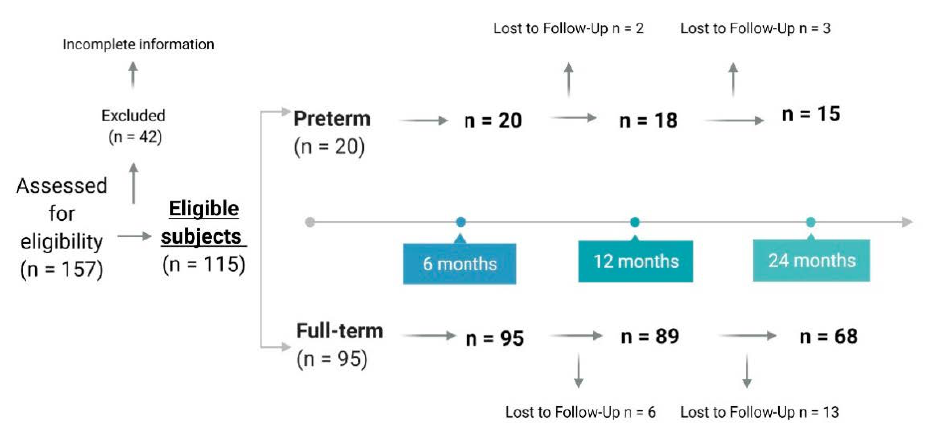
Figure 1. Scheme of participant enrollment and study